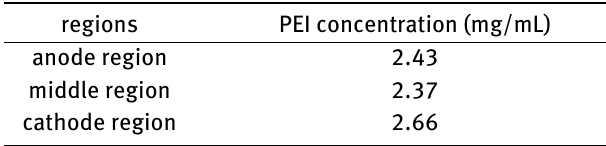
Table S1: The concentration of PEI in the hydrothermal solution of different regions.